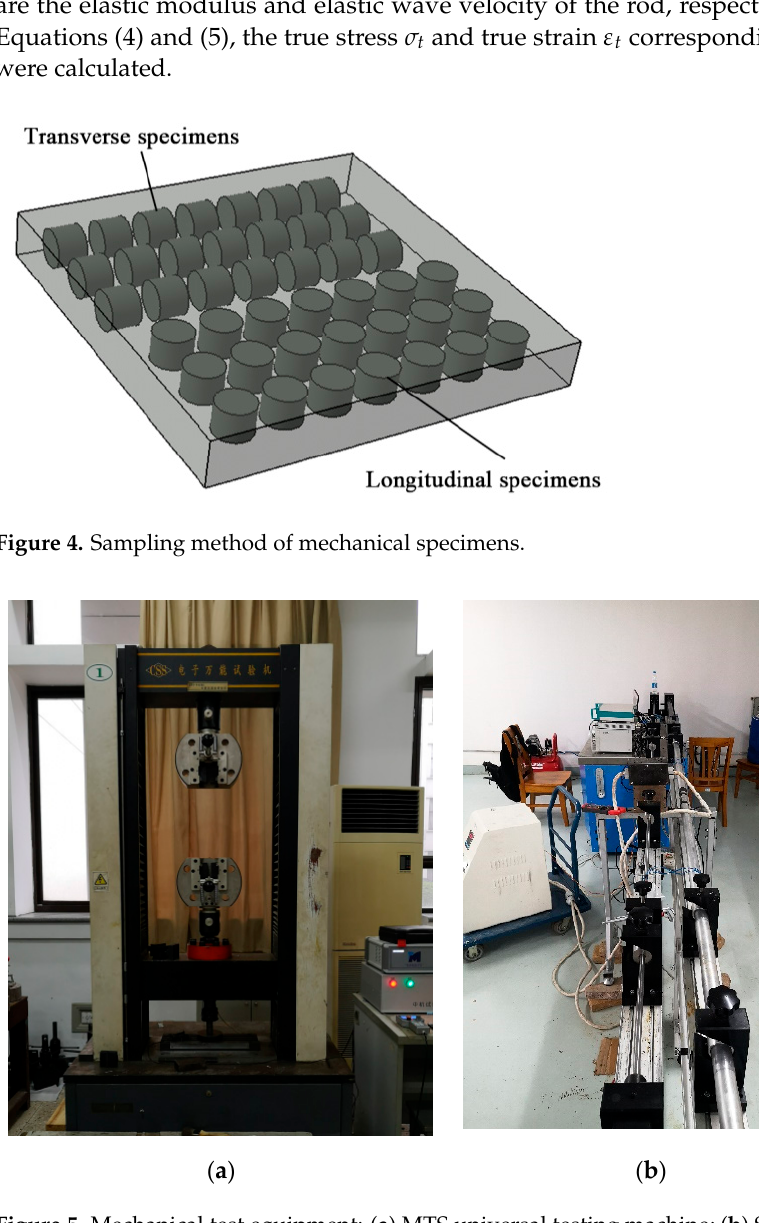
Figure 5. Mechanical test equipment: ( a ) MTS universal testing machine; ( b ) SHPB test equipment.